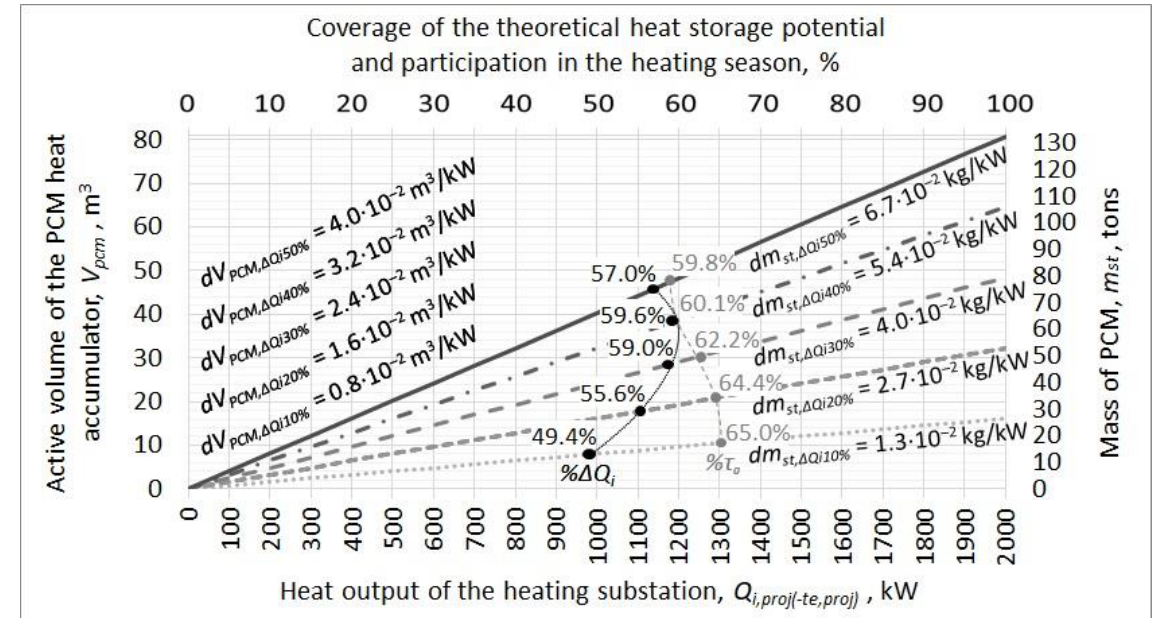
Figure 9 . Selection of the active volume of PCM heat accumulator and PCM mass . Figure 9. Selection of the active volume of PCM heat accumulator and PCM